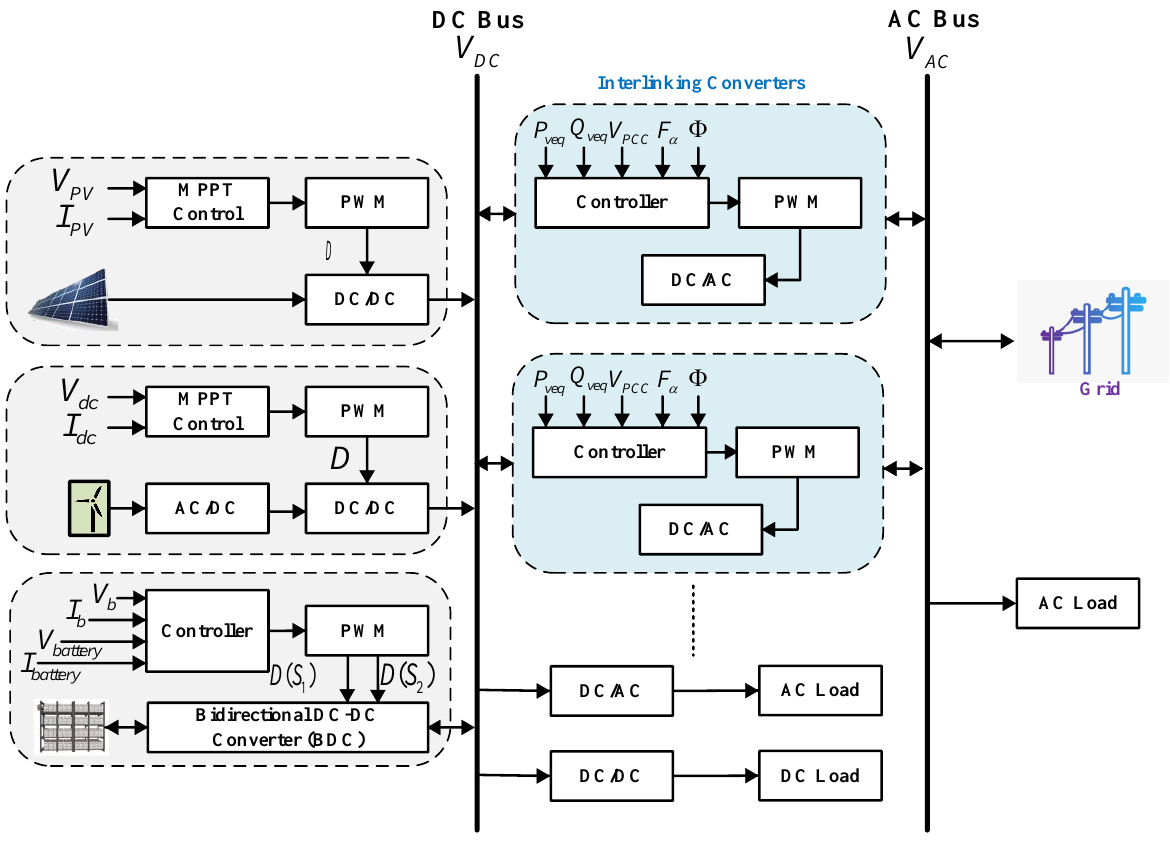
Figure 6. Control of AC/DC hybrid microgrid [23].